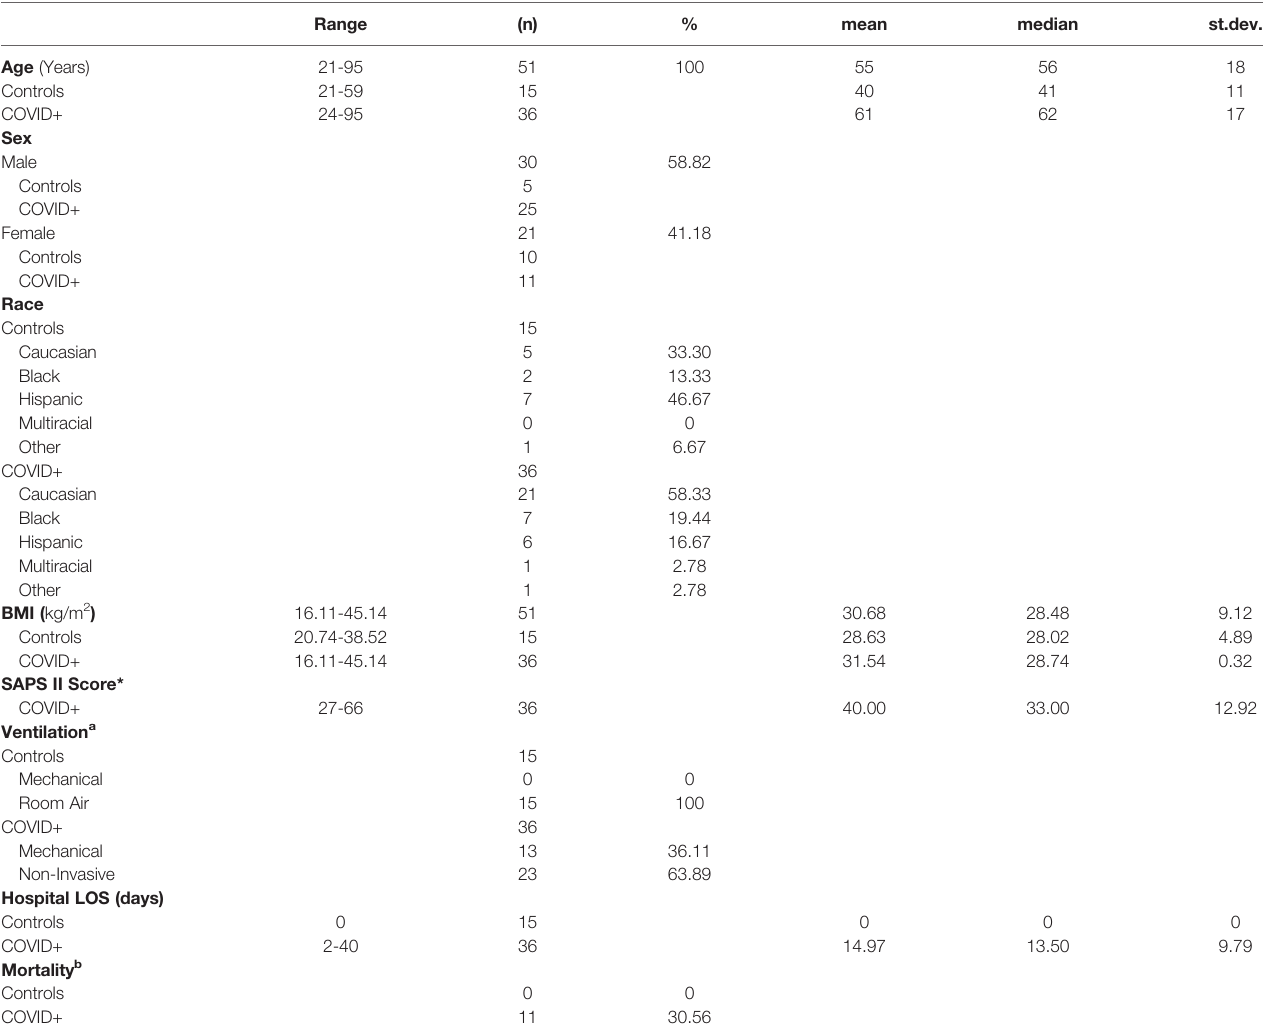
TABLE 1 | Patient demographics of COVID-19 Cohort 2020